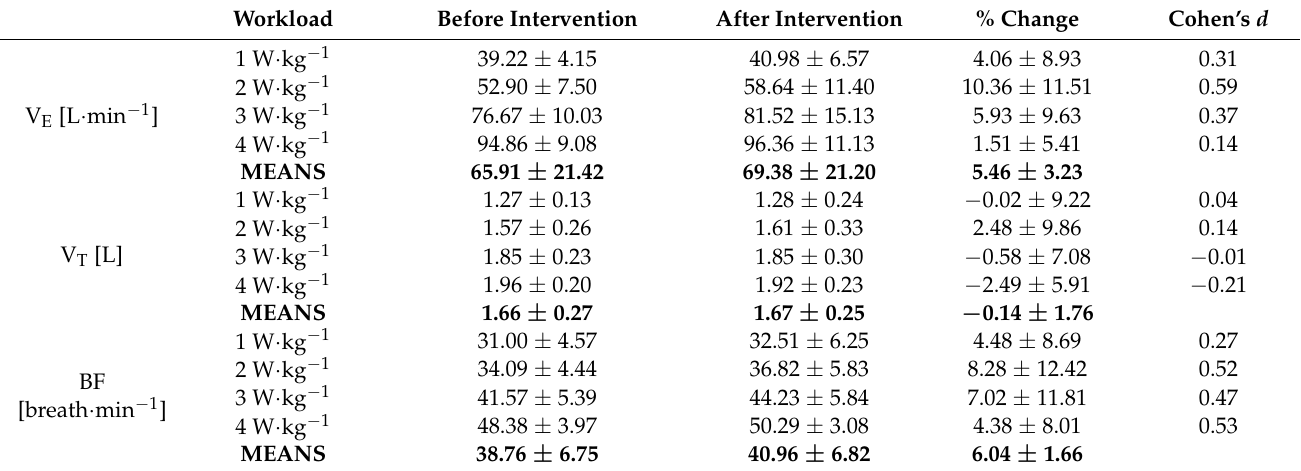
Table 2. Ventilation parameters before and after intervention in control group ( n =